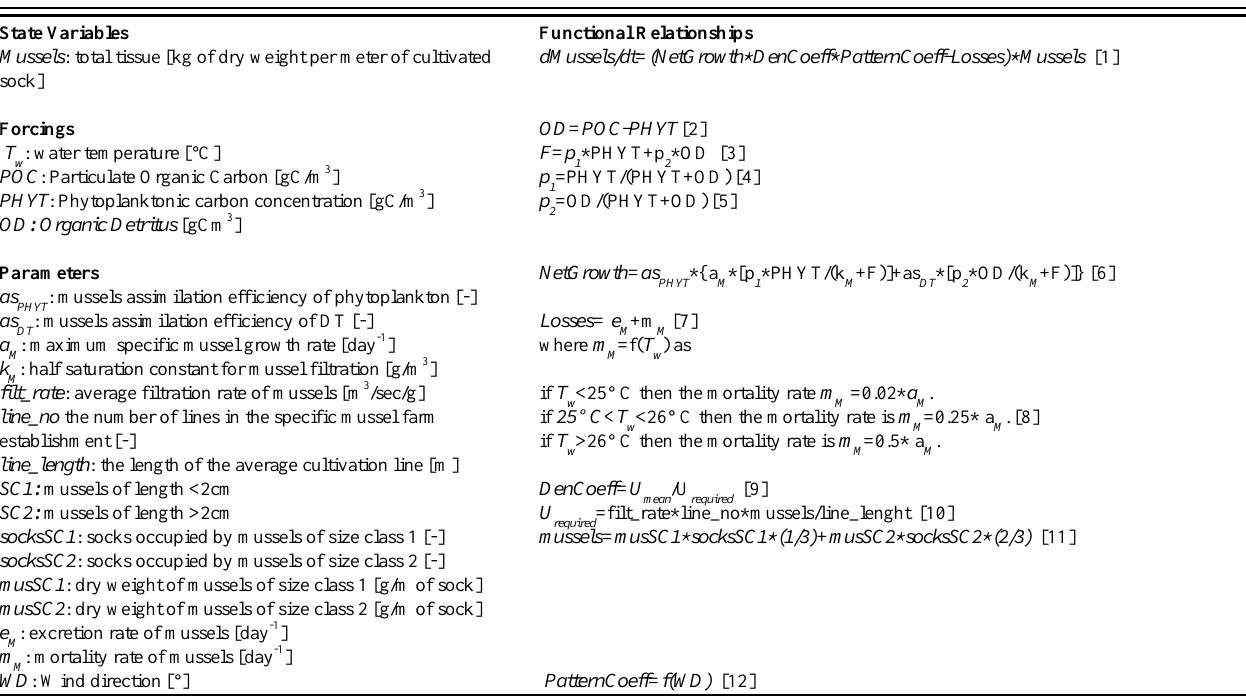
Table 2 . Ecological model state variables, forcings, parameters, and functional